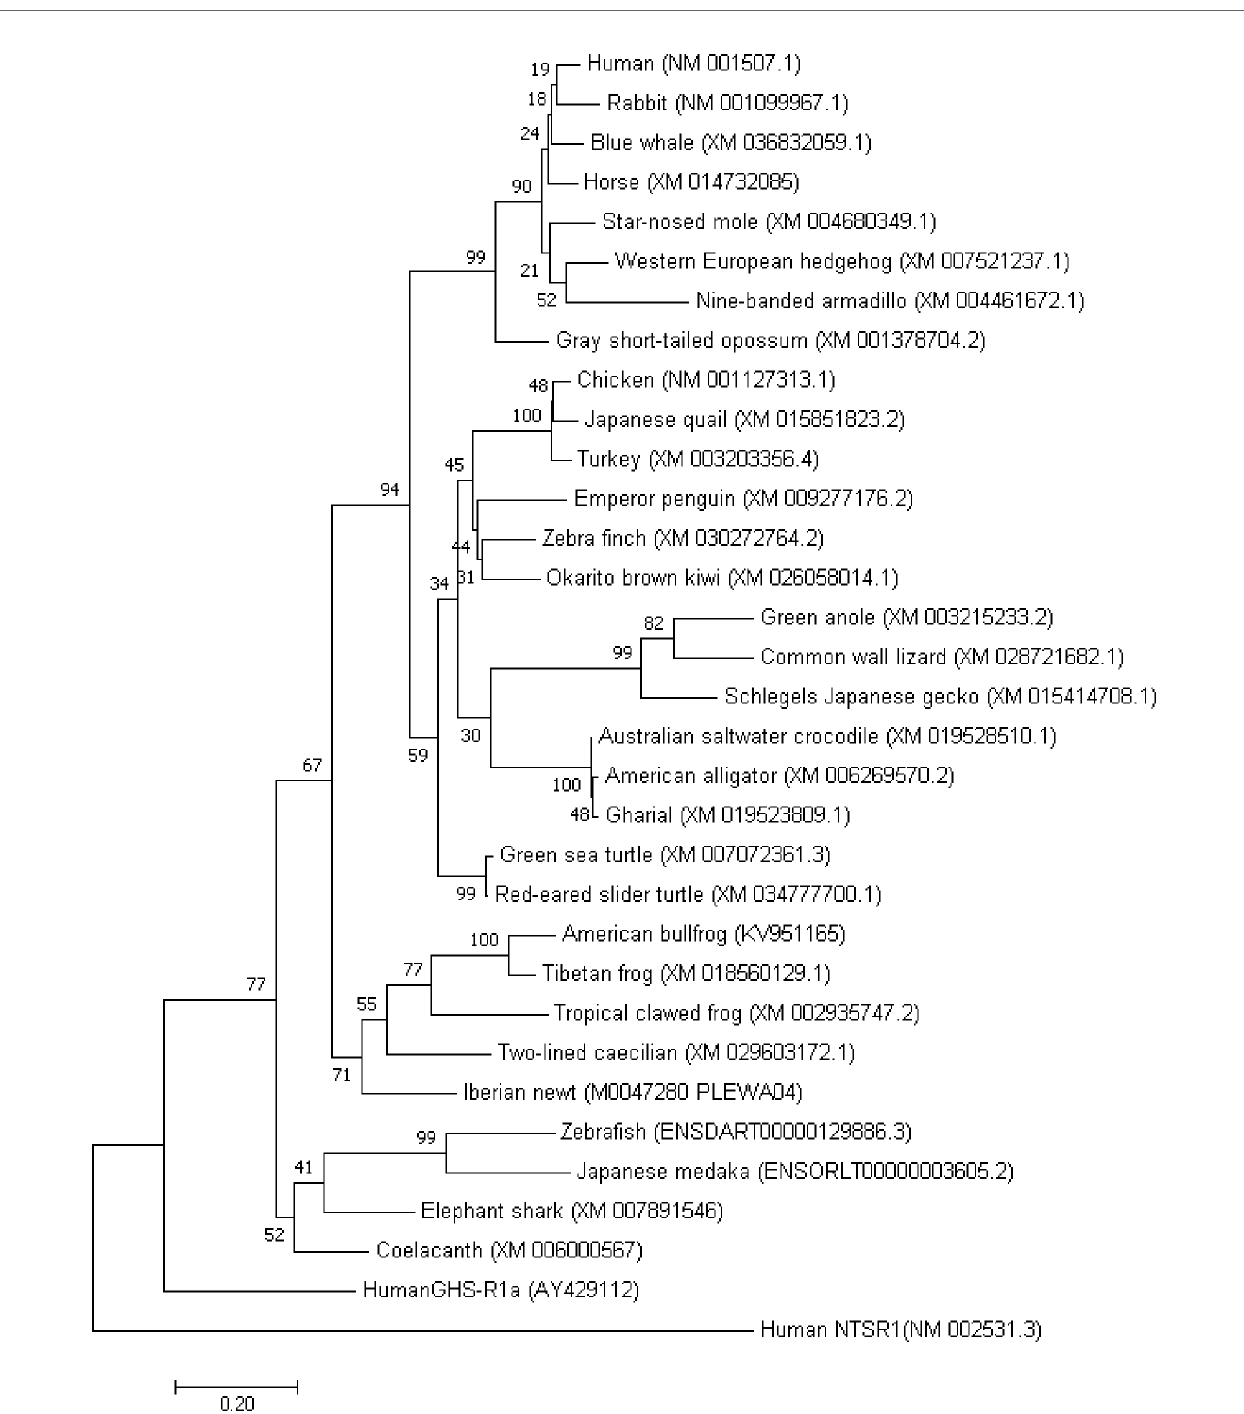
FIGURE 1 | Molecular phylogenetic analysis of motilin receptor in vertebrates. The evolutionary history was inferred by using the Maximum Likelihood method based on the JTT matrix-based model. The tree with the highest log likelihood (-7475.17) is shown. The percentage of trees in which the associated taxa clustered together is shown next to the branches. Initial tree(s) for the heuristic search were obtained automatically by applying Neighbor-Join and BioNJ algorithms to a matrix of pairwise distances estimated using a JTT model, and then selecting the topology with superior log likelihood value. The tree is drawn to scale, with branch lengths measured in the number of substitutions per site. The analysis involved 33 amino acid sequences. All positions containing gaps and missing data were eliminated. There were a total of 264 positions in the fi nal dataset. Evolutionary analyses were conducted in MEGA7.